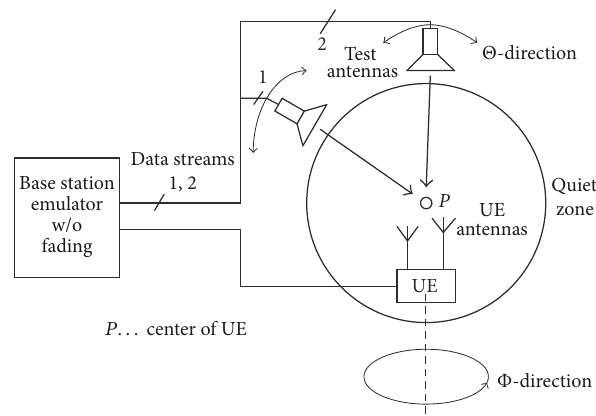
Figure 2: Measurement setup employing Two-Channel Method for the static radiated tests of the DM; BSE without channel emulator